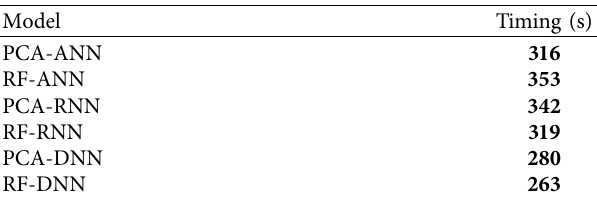
Table 5: Validation of the proposed method for computational timing analysis in Google Colab with 30 features.